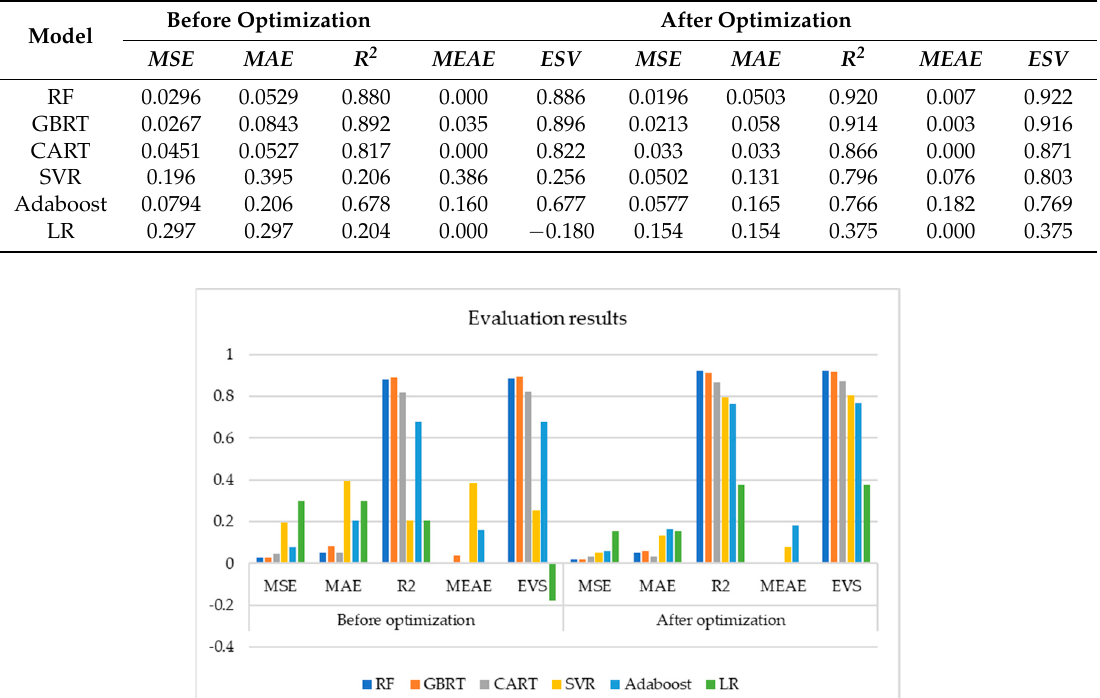
Table 4. Weight of each model.